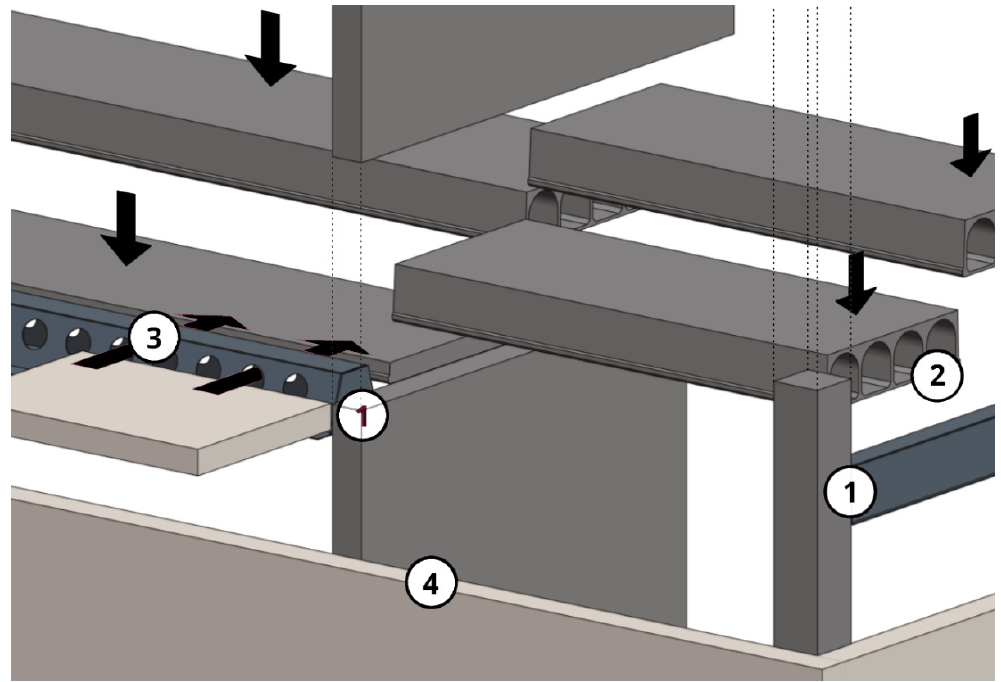
Figure 7. The structural principle of the plan: ( 1 ) delta beams were attached to the side of a concrete wall or beam with concealed brackets and with mounting plates; ( 2 ) hollow-core slabs rested on the flanges of the delta beam. Delta beams and hollow core slabs were joined by solder casting; ( 3 ) a cantilever balcony was attached to the building’s frame through the delta beam; ( 4 ) the cladding of the building was wood and non-load-bearing.